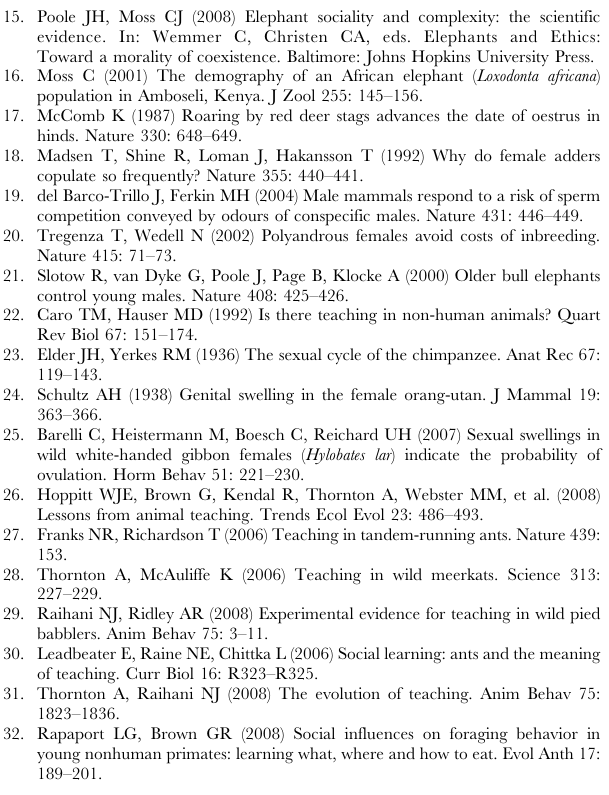
Table S1 Data table to accompany Document